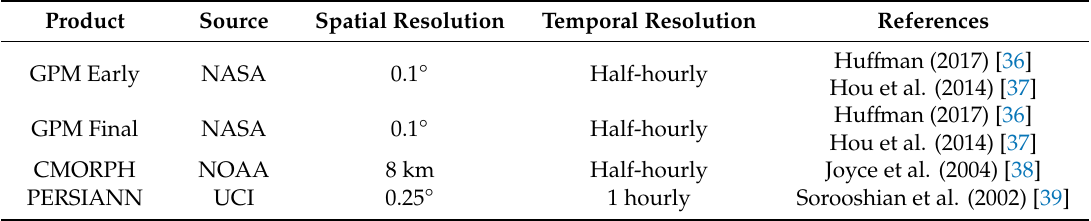
Table 2. List of satellite-based precipitation products used in the